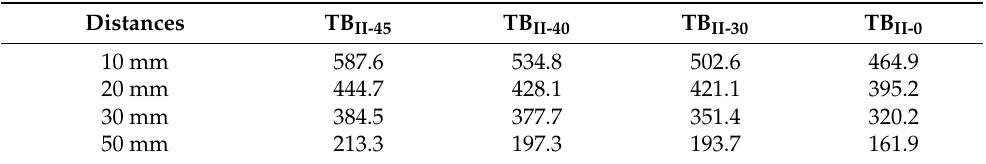
Table 6. Temperature values ( ◦ C) in different dosages and from different fire exposure distances at 60 min heating time.